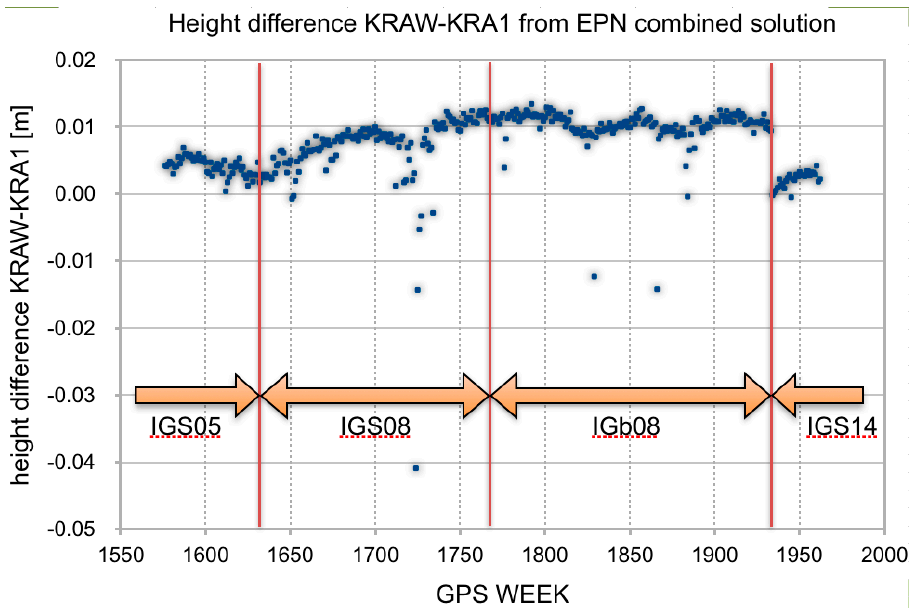
Figure 7. The time series for the height difference between KRAW–KRA1 calculated by EPN on the basis of several antenna correction catalogues (IGS ATX files) [32]. Alternatively, an independent PPP calculation was used—the Nevada Geodetic La- boratory (NGL). The facility provides permanent, fully, and freely available PPP results based on globally distributed permanent GNSS station data. Based on these data, the el- lipsoidal height differences between station KRAW and KRA1 for the period 2009.7– 2022.0 GPS weeks 1569–2190) were analysed (Figure 8). The results showed a mean dif- ference +1.83 mm (green line) and were compared to precise geometric levelling − 6.2 mm (red line). Both data provided inaccurate results, which was not a surprise, as they were based on the different antenna characteristics (IGS Antex files) of the KRAW antenna.